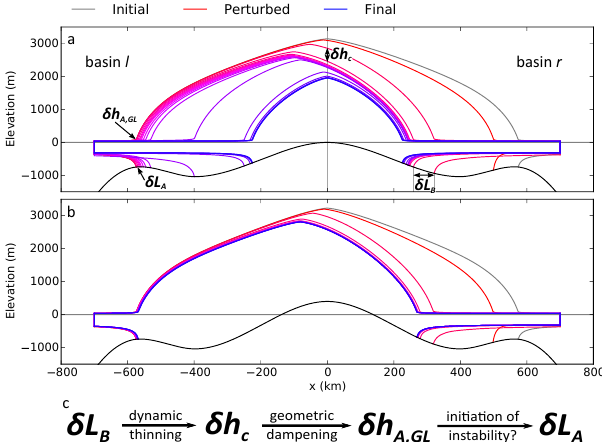
Figure 4. Profiles of the transient ice sheet between the end of per- turbation (red), and the final steady state (blue) for two different values of central bed elevation (a) b c = 0m (example of unstable scenario U, same as in Fig. 3a) and (b) b c = + 400m (example of stable scenario S). The time interval between two consecutive pro- files is 1kyr. (c) explains the mechanism of basin interaction con- ceptually with the notation depicted in panel (a)